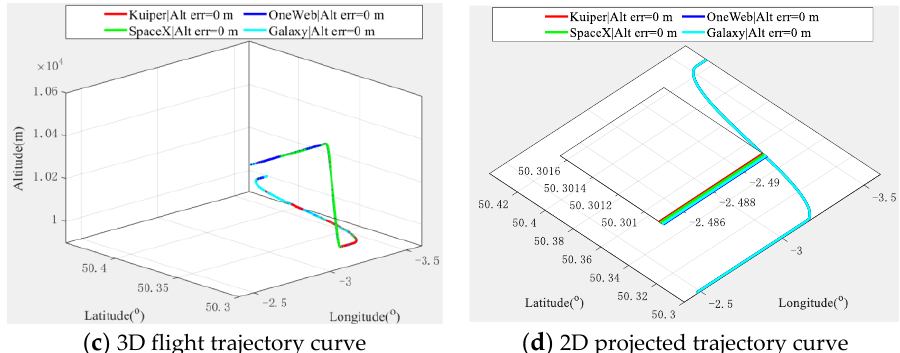
Figure 14. Comparison curve of altimeter-assisted multi-aircraft cooperative navigation and positioning algorithms based on the DWAPC-TSM system for different LEO constellations.